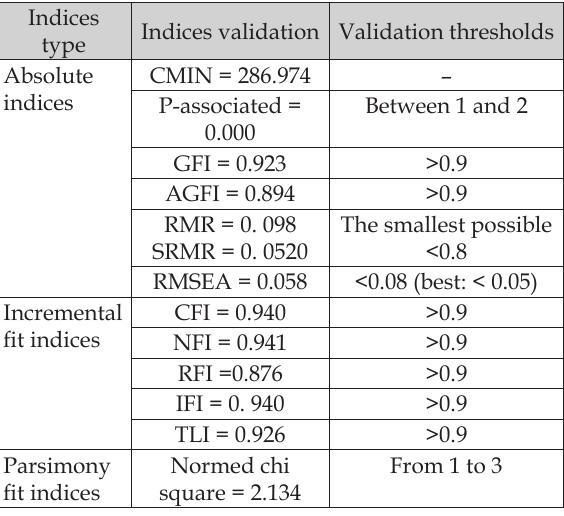
Table 2. Results synthesis of the CFA using AMOS and the adjustment indices relating to the model for meas- uring the experiential experience of public